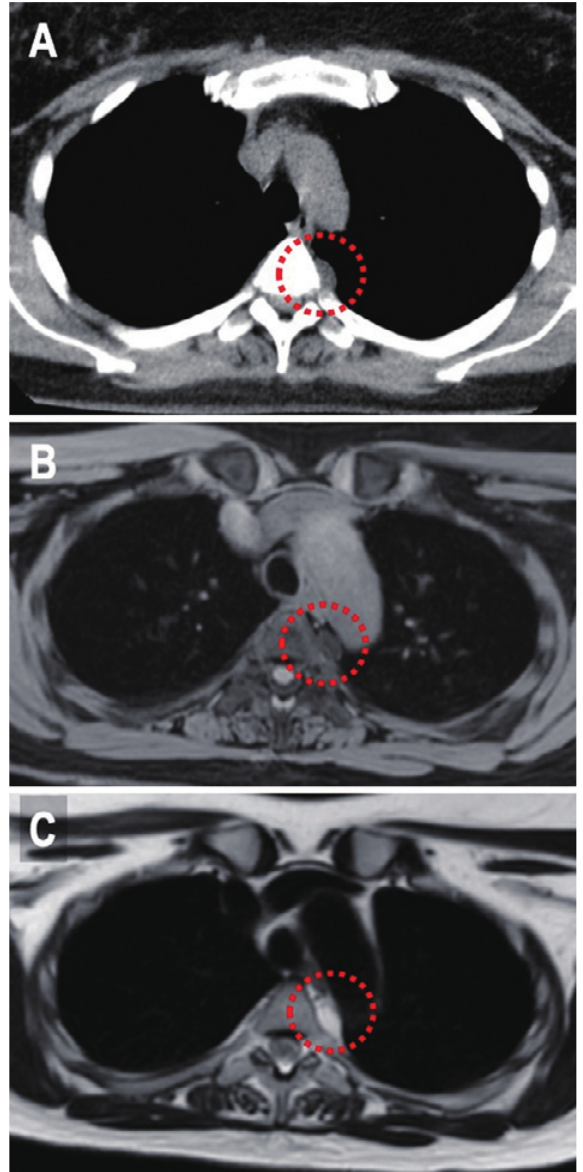
Figure 1. Preoperative images. ( A ) Plain chest computed to- mography revealed a well-defined 14 × 7 mm paravertebral mass at the level of the left 5th thoracic vertebra in the posterior medi- astinum. ( B ) Chest magnetic resonance imaging (MRI) shows a cystic mass with low signal intensity on T1-weighted images. ( C ) The cystic mass shows high signal intensity on T2-weighted MRI